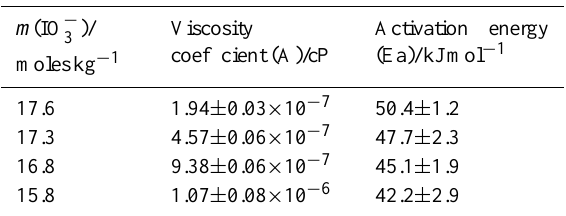
Fig. 3. Measured iodate solution densities at 293K as a function of m (IO − ) over a range of molalities up to and including that of 3 a saturated solution of HIO 3 . The solid line is a polynomial best- fit to the data (see Table 1). The vertical dashed line indicates the saturation molality of HIO 3 Fig. 2. Measured water activity values (open circles) at 293K for aqueous solutions of IO − from HIO 3 /I 2 O 5 over a range of molal- 3 ities up to, and including that of a saturated solution of each solid. The solid line is a fifth order polynomial best-fit to the data (see Ta- ble 1). The vertical dashed line indicates the saturation molality for I 2 O 5 and dotted line indicates the saturation molality for HIO 3 (or wt % – see top axis). The ideal water activity values (assuming full dissociation into ions) are indicated by the square dotted line. Table 2. Fitted Arrhenius parameters for the temperature dependent viscosity data (see Fig. 5).